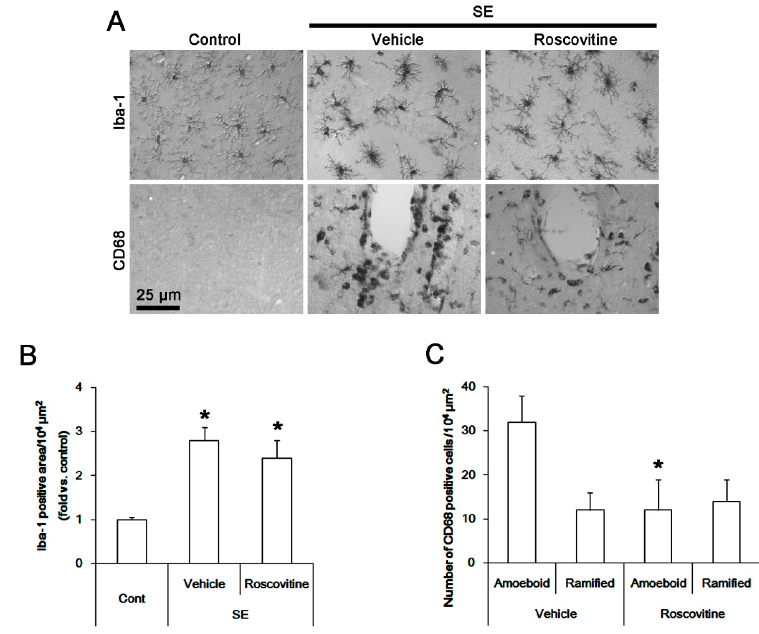
Figure 1. The effect of roscovitine on microglia activation and monocyte infiltration in FPC following SE . Iba-1 microglia show hypertrophic morphologies with hyper-ramified processes that are covered by a lot of thorny spine following SE. In addition, CD68 cells showing amoeboid or round shapes are detected in the FPC following SE. These CD68 cells are localized in perivascular brain parenchyma. A few CD68 cells exhibited hyper-ramified shapes. Although roscovitine does not influence Iba-1 microglia transformation, it reduces the number of CD68 amoeboid cells without altering that of CD68 hyper-ramified cells. ( A ) Representative images for Iba-1 and CD68 positive cells. ( B , C ) Quantification of the effect of roscovitine on Iab-1 positive area ( B ) and the number of CD68 amoeboid and ramified cells ( C ) following SE. Error bars indicate SEM ( *p < 0.05 vs. control- or vehicle-treated animals; n = 7, respectively).